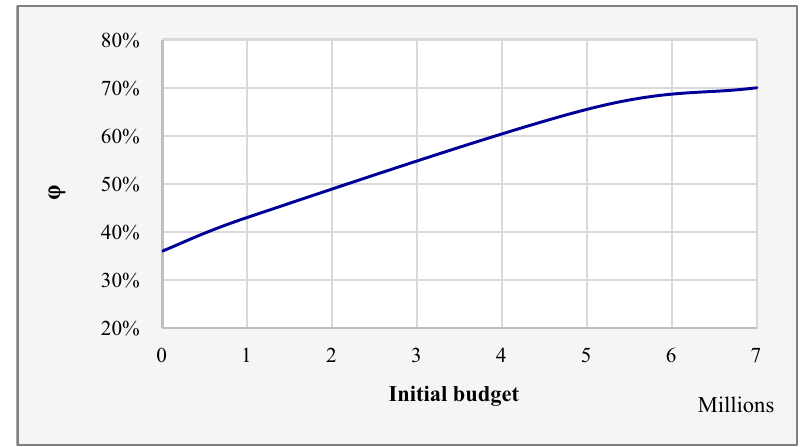
Fig. 16 The result of analyzing the sensitivity of φ to the changes in the initial